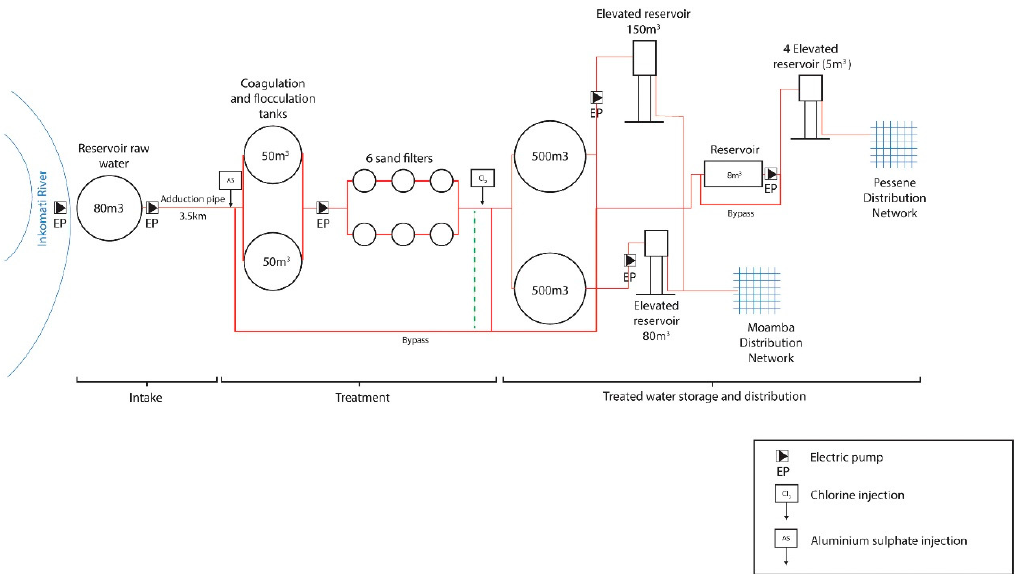
Figure 6. Detail of the bypass in the water treatment station. In red the bypass in its current state. The green dotted line represents how it should be to prevent adding the chlorine manually.